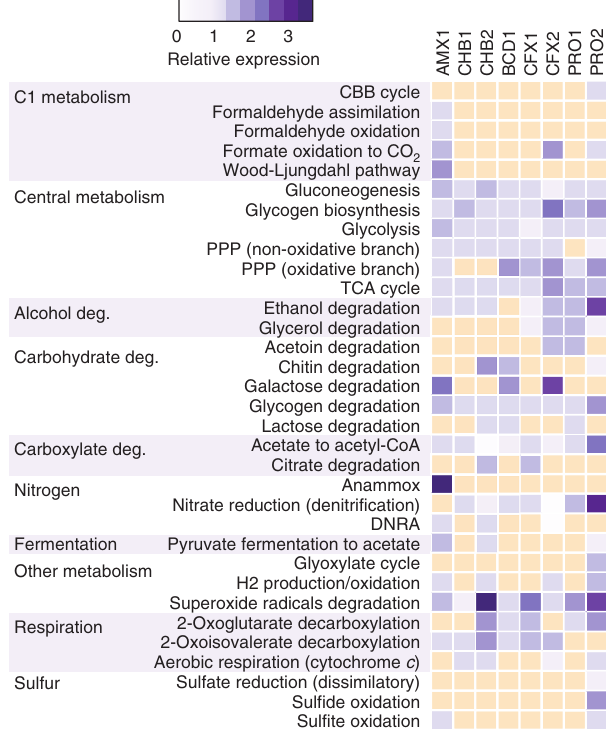
Figure 4 | Relative gene expression of major carbon and energy metabolic pathways encoded by each MAG. Colour intensity represents gene expression, based on mapping of metatranscriptomic reads to the metagenomic assembly. Gene expression was relativized by median RPKM values calculated across each ORF in a given MAG (Methods section). A value of 1 equals median expression in a given genome. Yellow box indicates pathway absence. Anammox metabolic pathway in the AMX1 genome had a relative expression value of 15. See Supplementary Data 3 for a detailed summary of all reconstructed metabolic